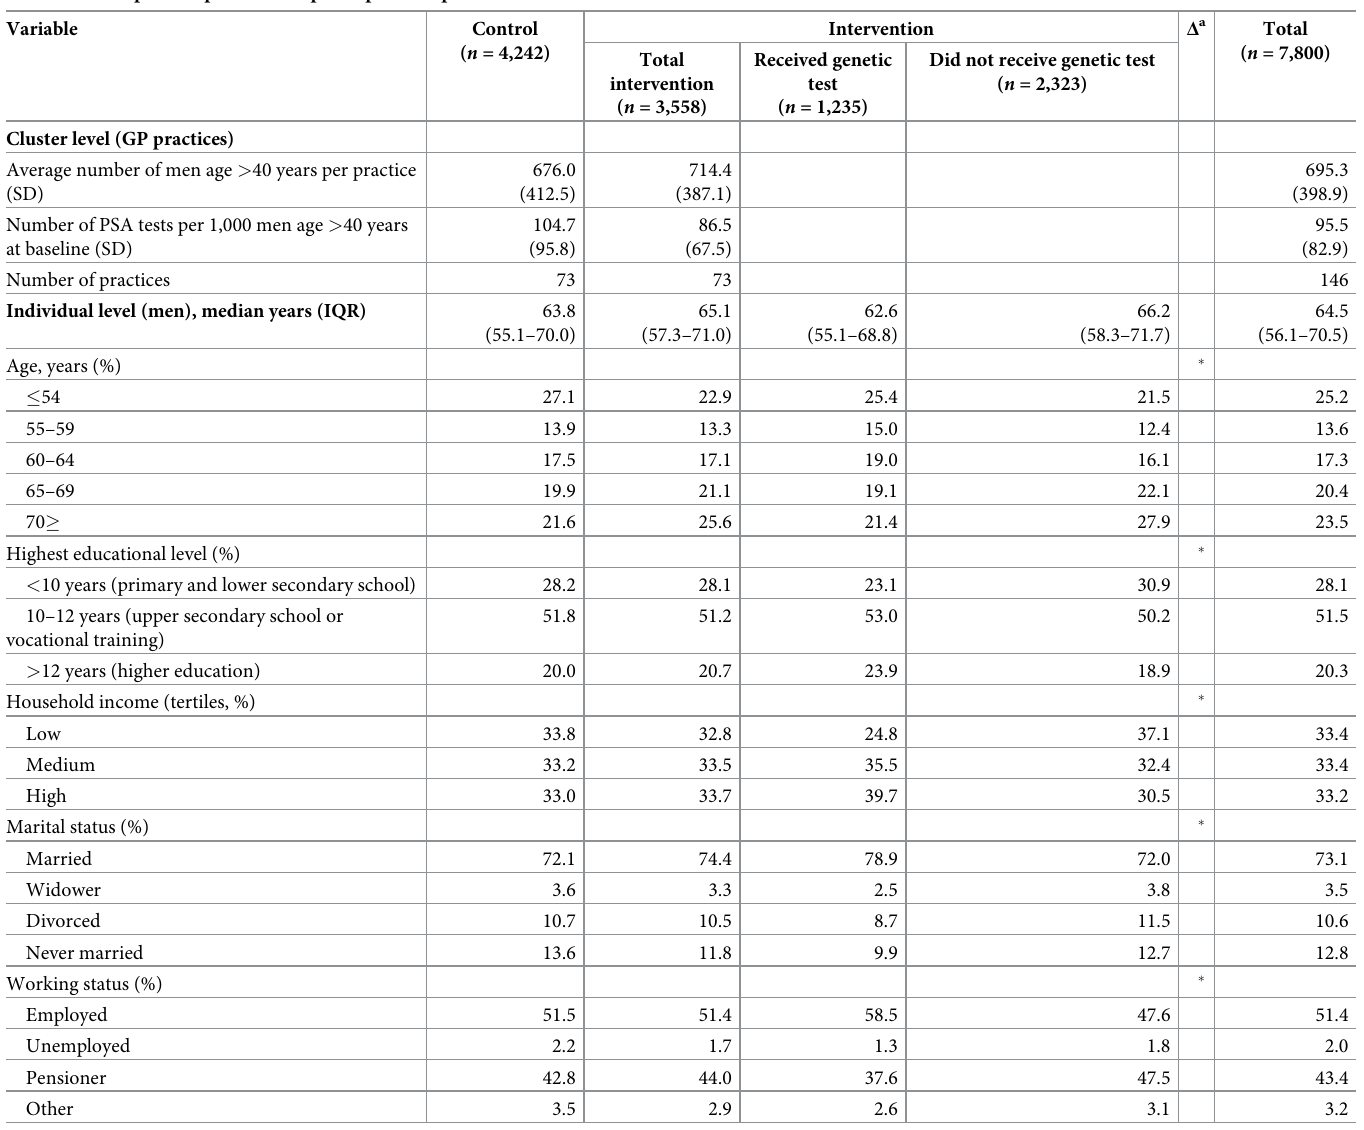
Table 1. Description of practice and participant sample at